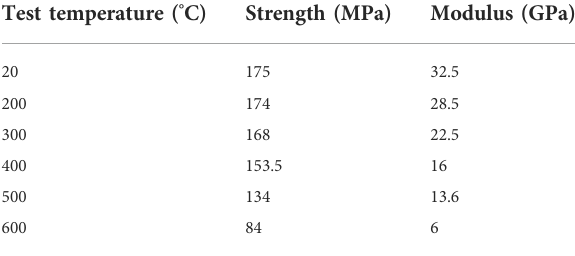
TABLE 1 Test results of granite at different temperatures.